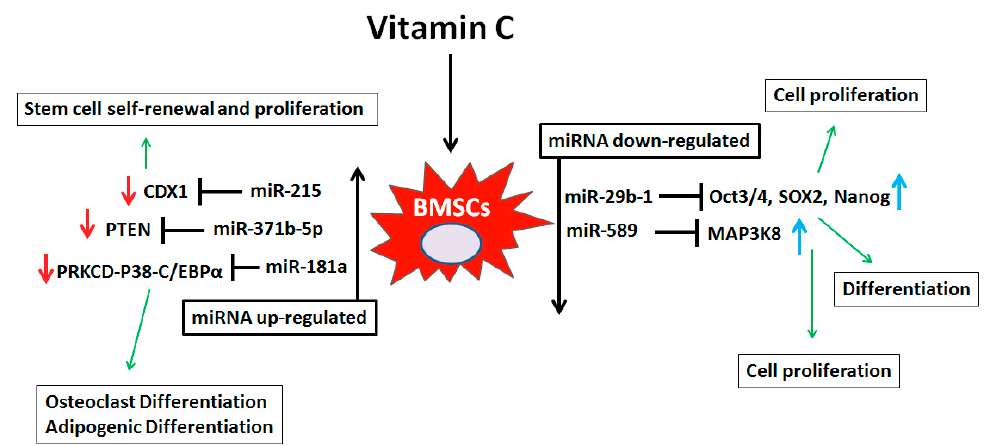
Figure 5. Vitamin C dependent miRNAs mediated signaling in human bone marrow stromal cells. Schematic diagram showing the contribution of key miRNAs in cell proliferation and differentiation of human bone marrow stromal cell.